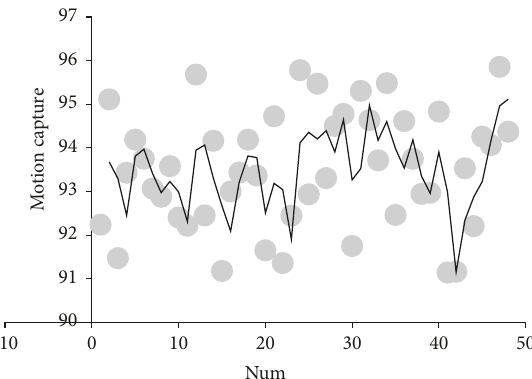
Figure 8: Motion capture effect. Statistical analysis is carried out on the practical effect of the system in this paper, and the quantitative processing method is used to obtain it.